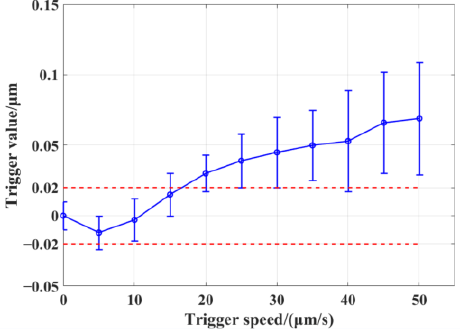
Figure 10. The relationship between the trigger speed of the moving axis and the coordinate value collected by the moving axis.